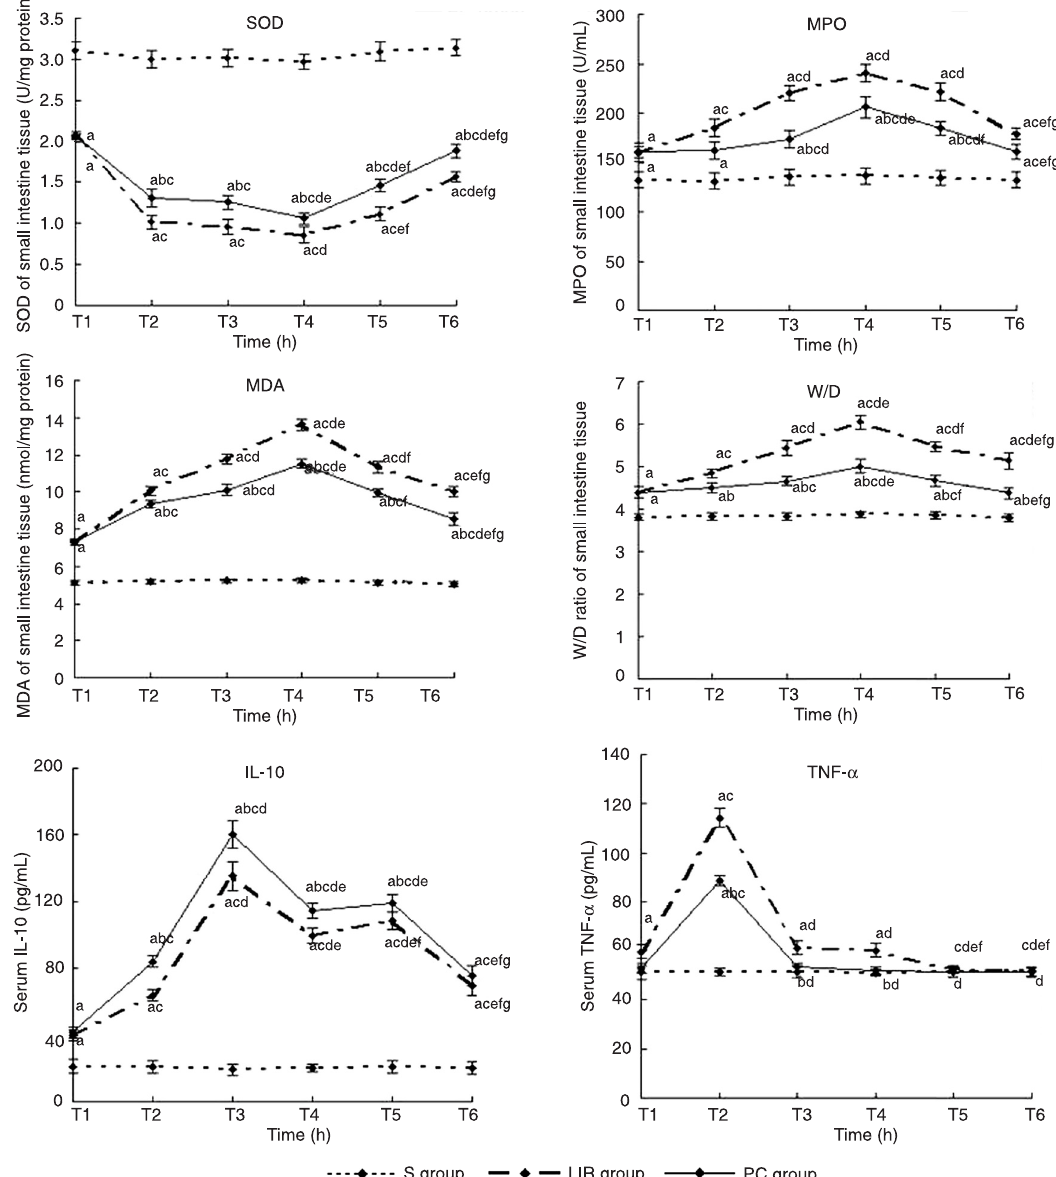
Figure 2. Effect of limb ischemia and reperfusion on superoxide dismutase (SOD), myeloperoxidase (MPO), malondialdehyde (MDA) concentrations and wet to dry weight ratio (W/D ratio) of small intestinal tissue, serum interleukin-10 (IL-10), and tumor necrosis factor-α (TNF-α) with repefusion times in the rat groups. Group S: sham-operated group; group LIR: limb ischemia-reperfusion group, and group PC: post-conditioning group. Reperfusion time: T1 = immediate (0 h); T2 = 1 h; T3 = 3 h; T4 = 6 h; T5 = 12 h, and T6 = 24 h. Data are reported as means ± SD for 6 rats in each group. a P < 0.05 vs group S; b P < 0.05 vs group LIR; c P < 0.05 vs T1; d P < 0.05 vs T2; e P < 0.05 vs T3; f P < 0.05 vs T4; g P < 0.05 vs T5 (one-way